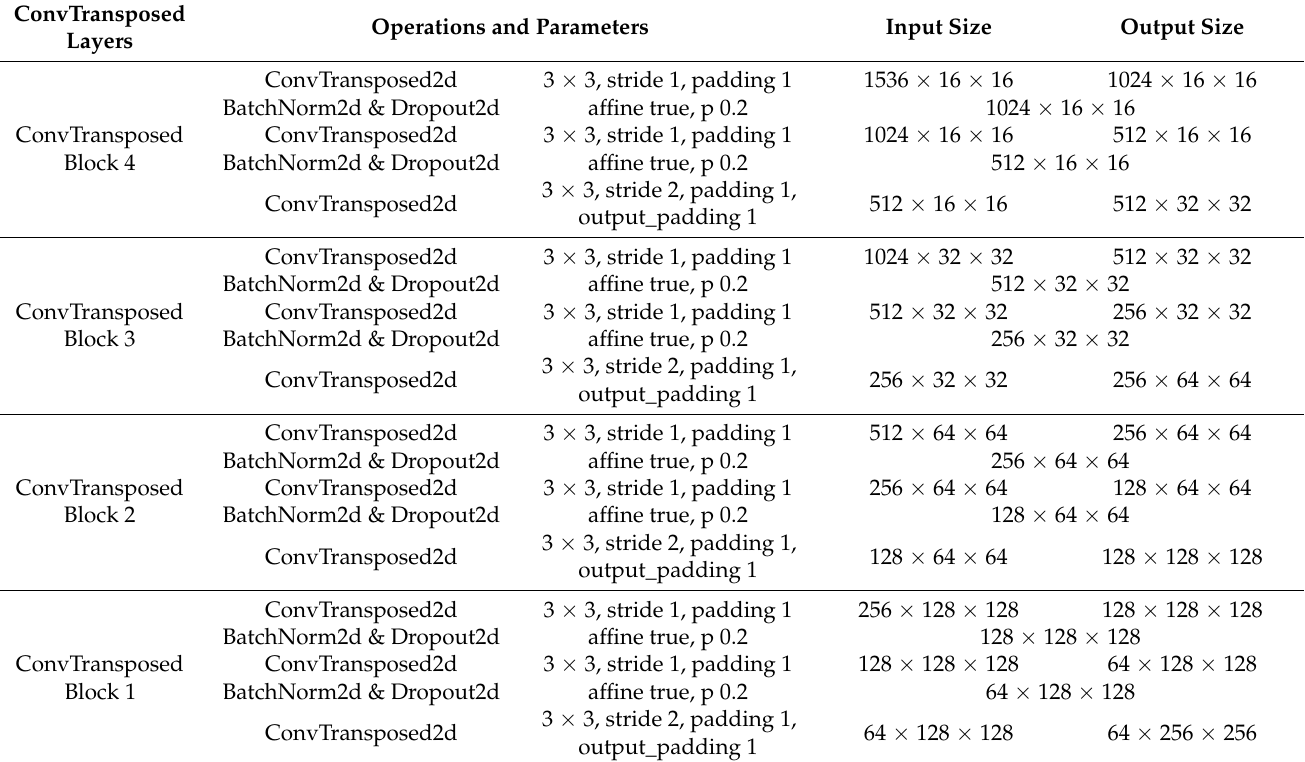
Table 1. The architectural details for our ConvTransposed layers. ConvTransposed2d, BatchNorm2d, and Dropout2d indicate transposed convolution, batch normalization, and dropout operations, respectively; the next subcolumn gives the corresponding